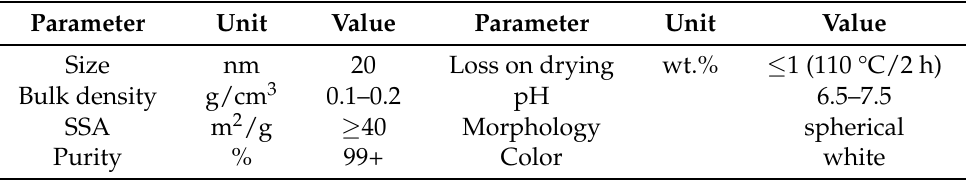
Table 2. Technical parameters of ZnO nanoparticles